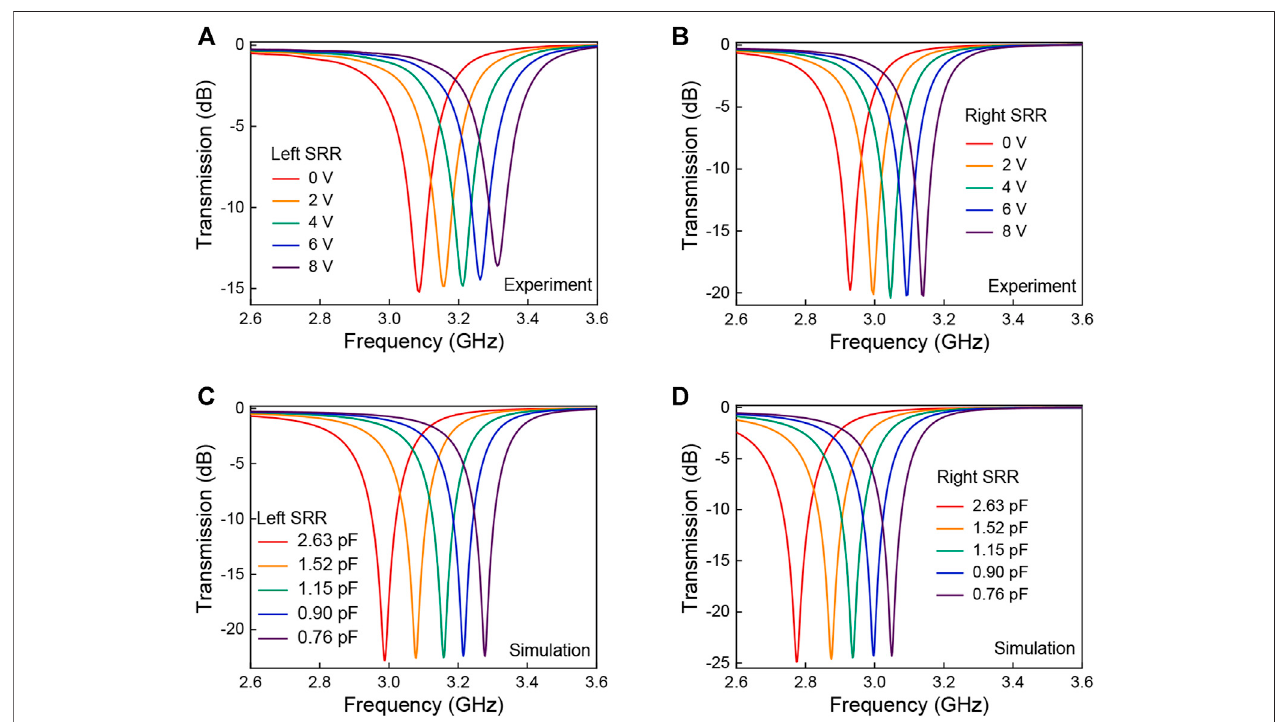
FIGURE 5 | Measured (A) , (B) and calculated (C) , (D) transmission spectra of the SRR alone with different bias voltages (from 0 to 8 V) and corresponding capacitances (from 2.63 to 0.76 pF): the left SRR alone (A) , (C) , and right SRR alone (B) , (D) .